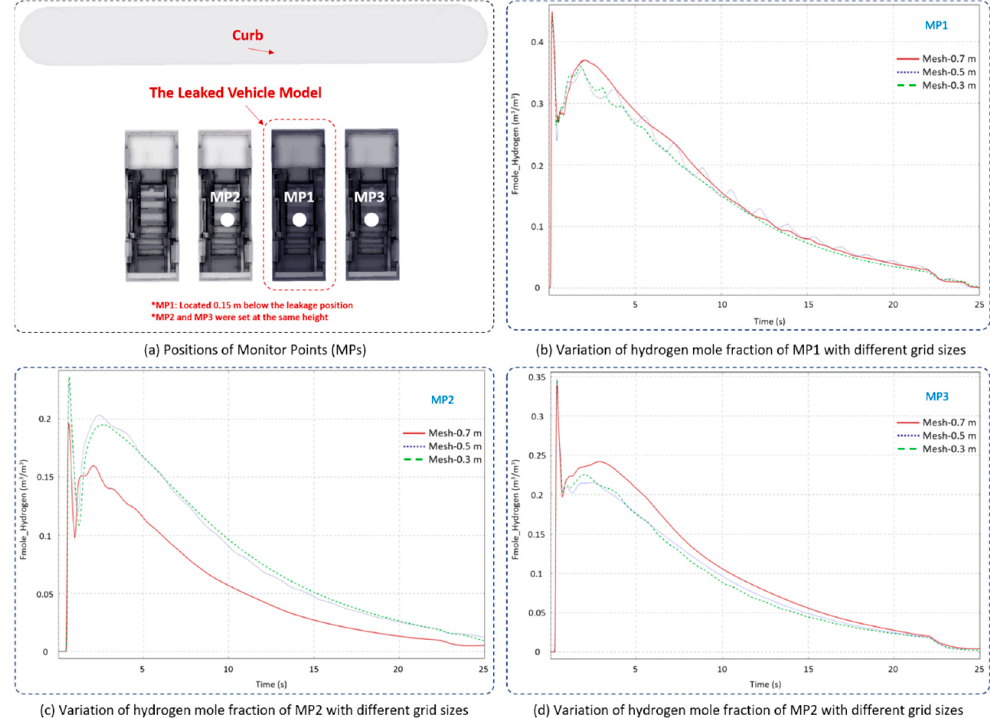
Figure 3. Simulated hydrogen mole fraction variation with time under different grid dimensions.